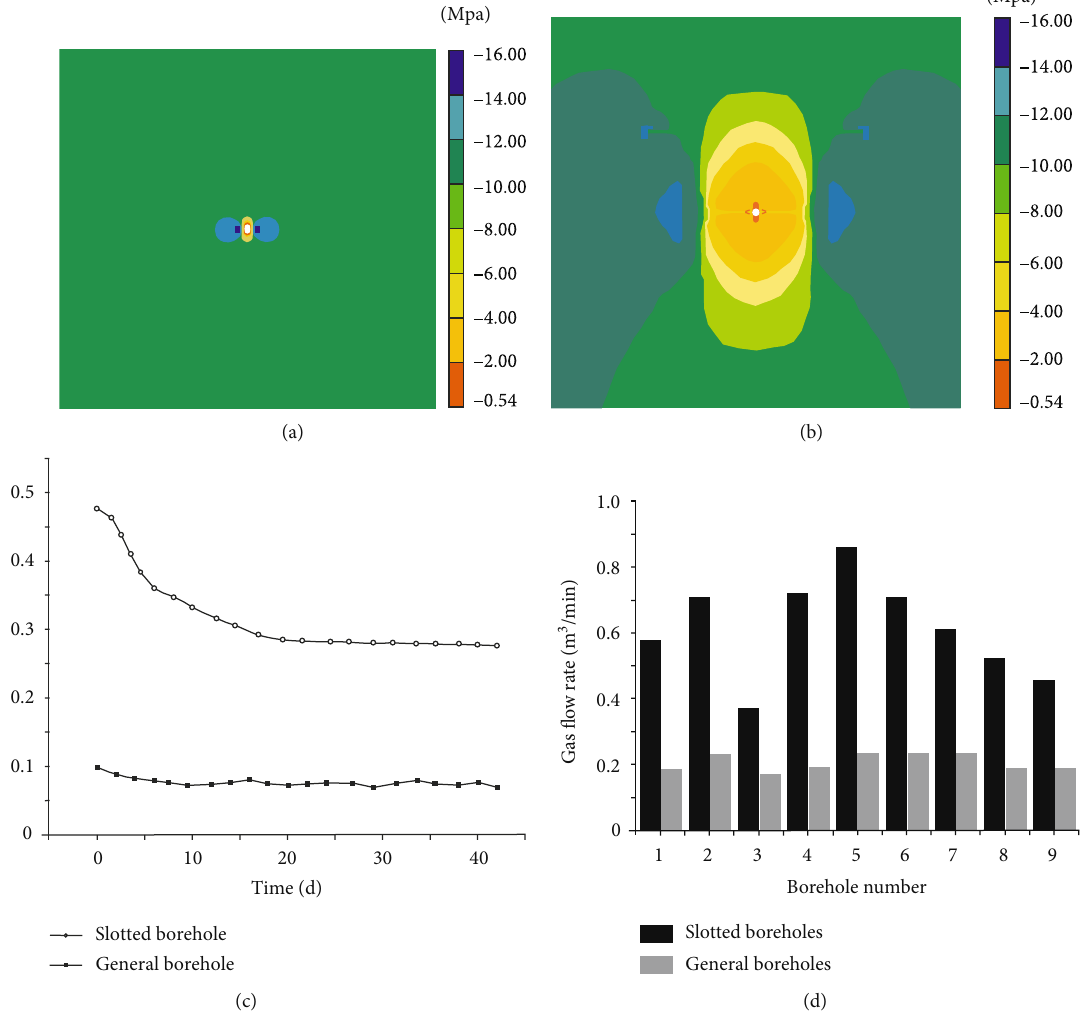
Figure 6: The di ff erences in gas production e ff ect for general borehole and slotted borehole. (a) Vertical stress distribution of general borehole. (b) Vertical stress distribution of the slotted wellbore. (c) The di ff erence in gas fl ow rate with varied time. (d) The di ff erence in gas fl ow rate with varied